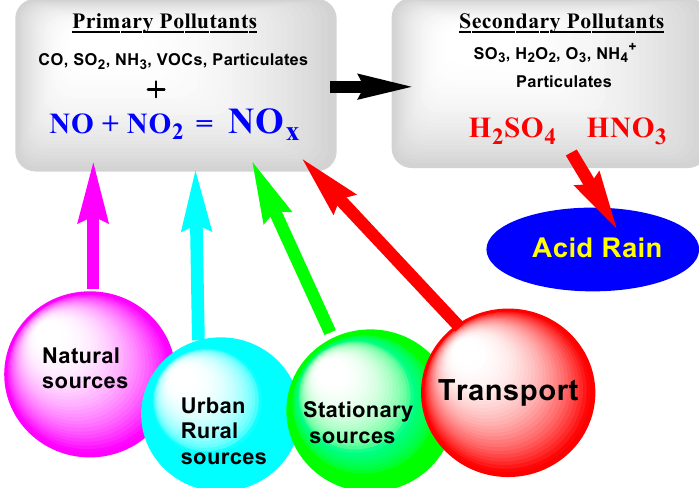
Figure 1. Graphic illustrating the natural and anthropogenic sources of atmospheric pollution together with primary and secondary atmospheric pollutants from various sources that ultimately lead to the formation of acid rain.